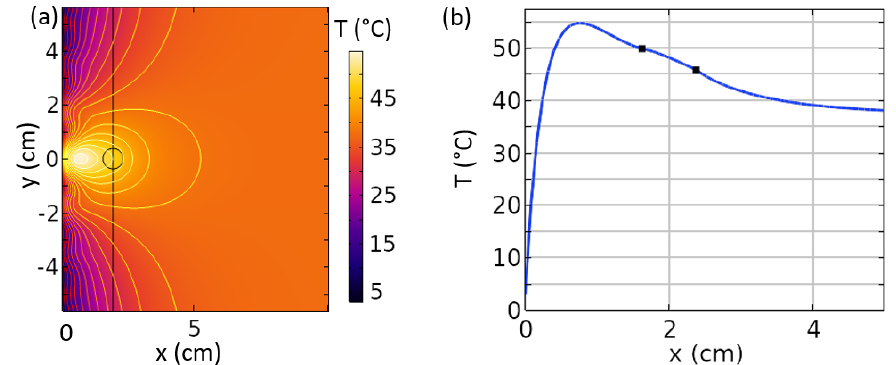
Figure 10. ( a ) Temperature distribution within a biological volume when attempting to ablate tumorous tissue with an NFP. The focal plane is represented by the black line at x = 2 cm, and the tumor outline is shown centered at x = 2 cm, y = 0. ( b ) A plot of the temperature along the line y = 0 with the boundaries of the tumor marked by black dots. Maximal heating does not occur within the tumor, but is generated at a shallower depth due to the evanescent nature of the